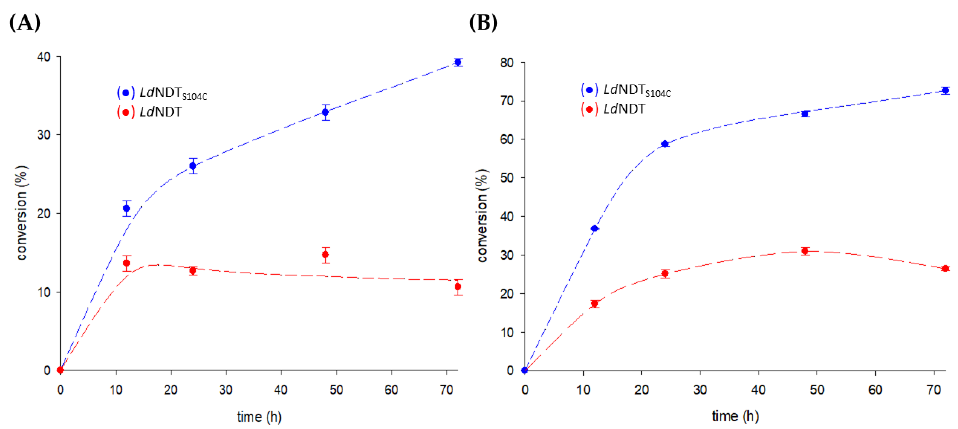
Figure 6. Time–course of enzymatic production of nelarabine catalyzed by Ld NDT and Ld NDT S104C . ( A ) ara U:6-MeOGua (1:1). ( B ) ara U:6-MeOGua (3:1). All determinations were carried out in triplicate, and the standard error of the mean is calculated using the standard deviation.